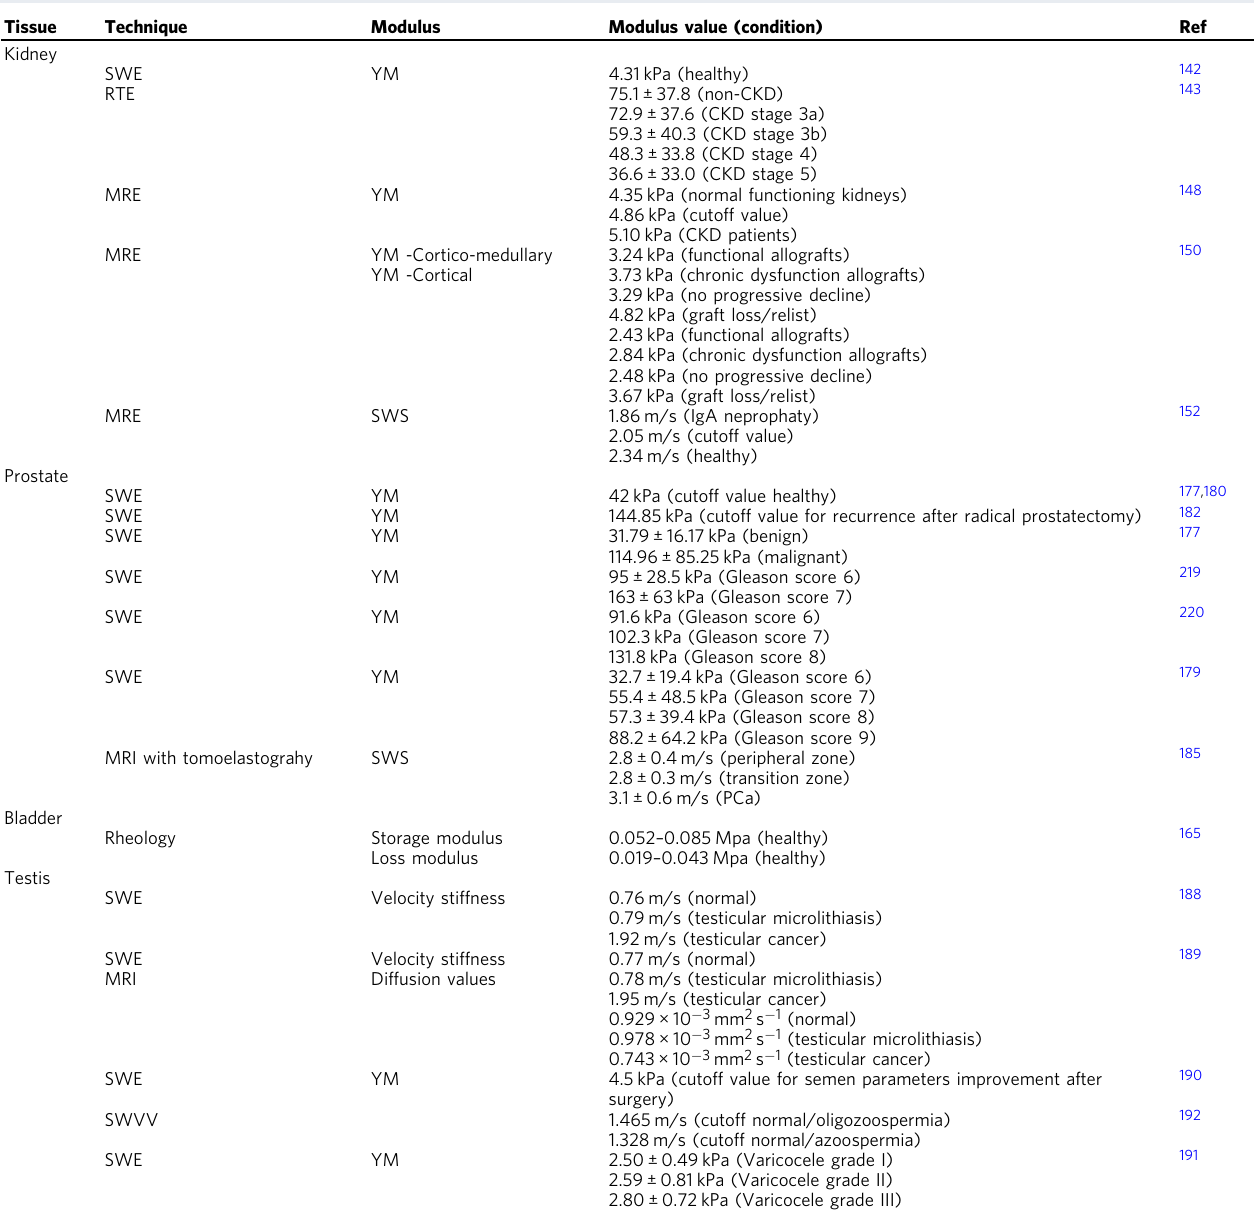
Table 2 Mechanical moduli of human urological tissues. Tissue